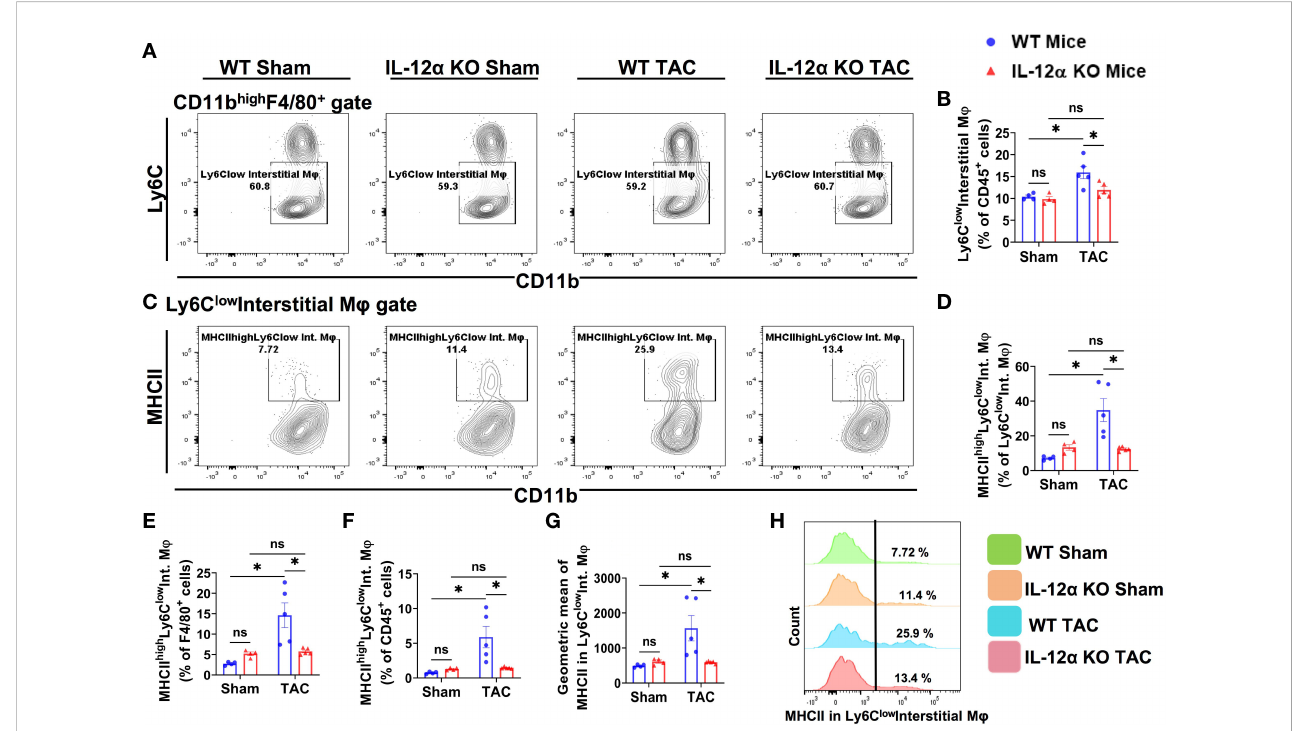
FIGURE 7 IL-12 a KO ameliorated TAC-induced accumulation of Ly6C low interstitial macrophages (Ly6c low CD11c low CD11b high F4/80 + ) and their activation. (A) Representative gating plots of Ly6C low interstitial macrophages. (B) Quanti fi ed percentage of Ly6C low interstitial macrophages within CD45 + leukocytes. (C) Representative plots for MHCII high macrophages within Ly6C low interstitial macrophages. (D – F) Percentages of MHCII high Ly6C low interstitial macrophages within Ly6C low interstitial macrophages, F4/80 + , and CD45 + cells, respectively. (G) Mean fl uorescent intensity of MHCII in Ly6C low interstitial macrophages. (H) Representative histogram showing MHCII expression in Ly6C low interstitial macrophages. *p<0.05, ns, non-signi fi cant.